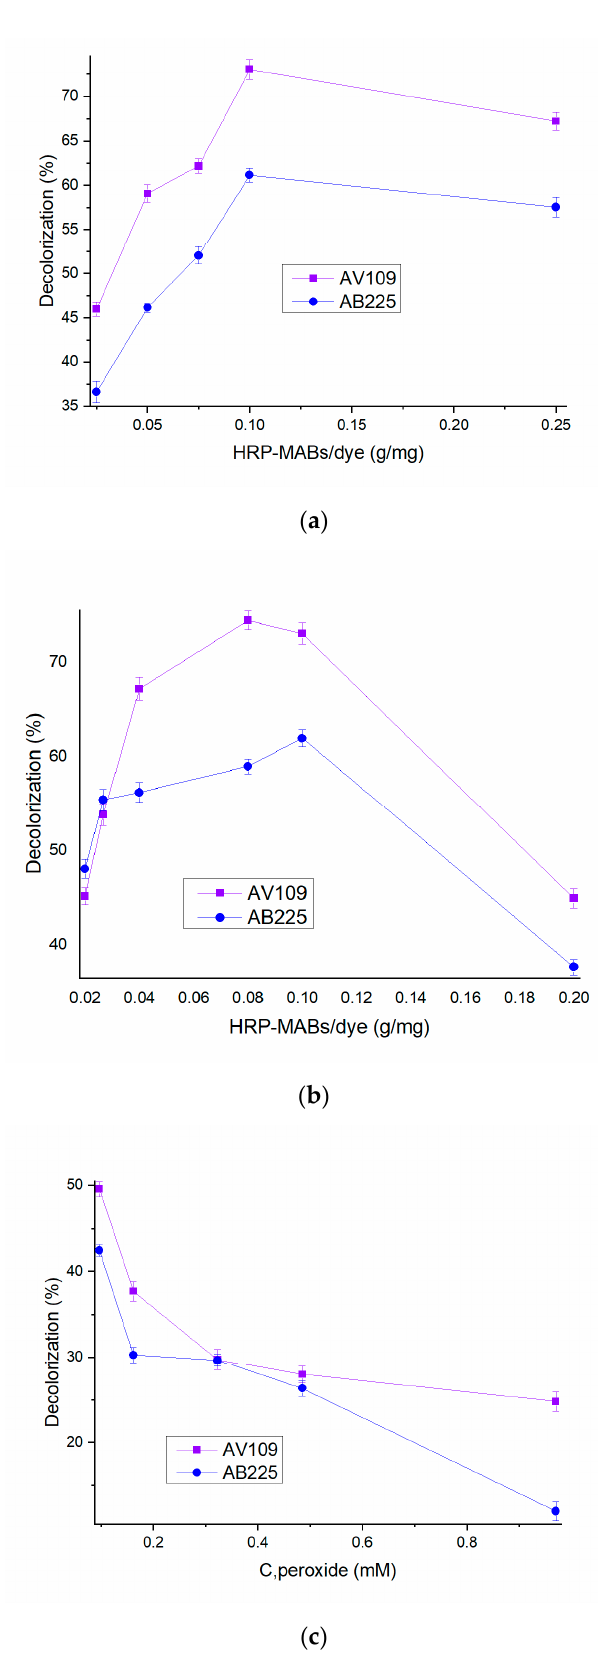
Figure 9. Effects of ( a ) HRP-MABs mass for decolorization of both dyes, AV 109 and AB225; ( b ) initial H 2 O 2 concentration (1 mm beads loaded by using initial enzyme concentration of 10 mg/g